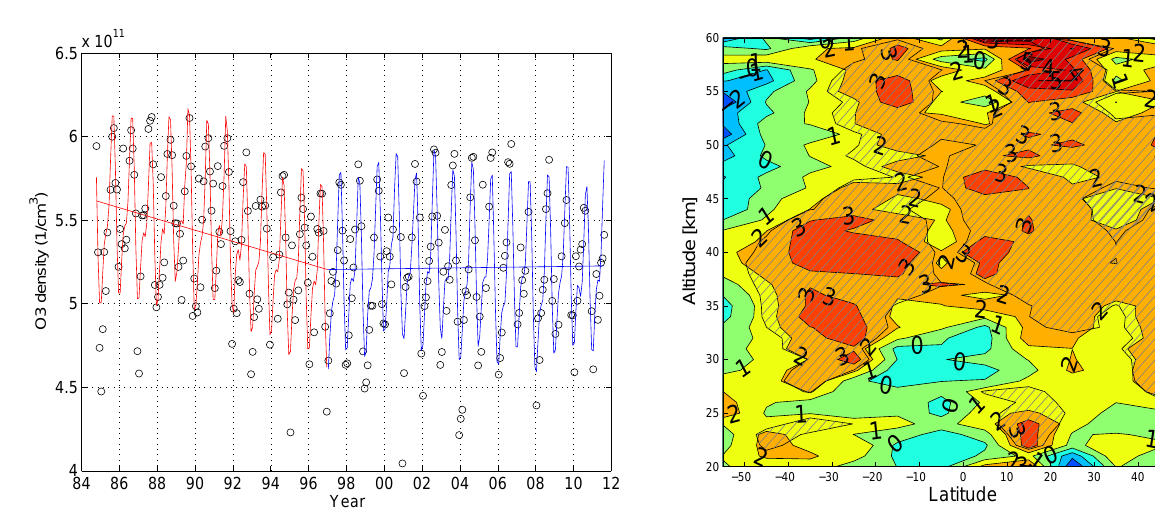
Fig. 12. An example of the fit at 40km between 40–50 ◦ N for the combined SAGE II–GOMOS monthly data. The data points are black circles. The inflection year is 1997. The red solid curve and red line line represent the fit and linear trend for 1984–1997, respec- tively. The blue solid curve and blue line represent the fit and linear trend for 1997–2011, respectively.